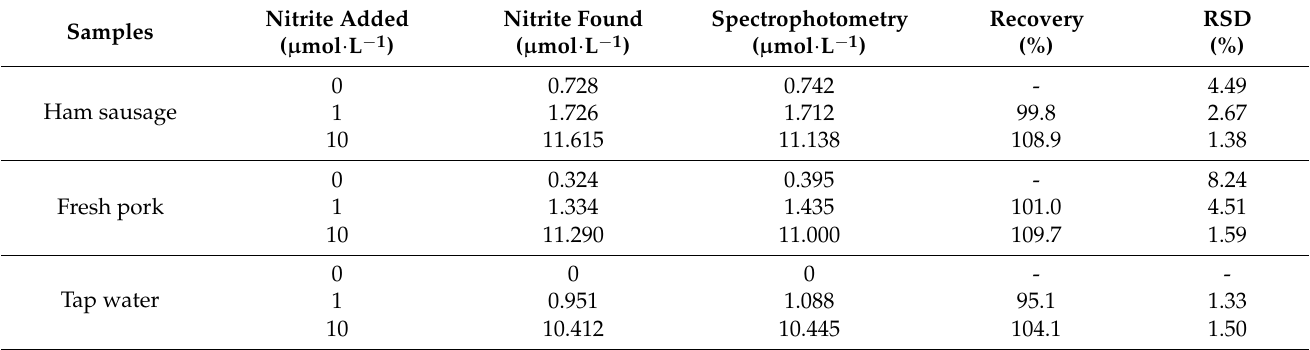
Table 2. The result of nitrite determination in real samples by developed SERS